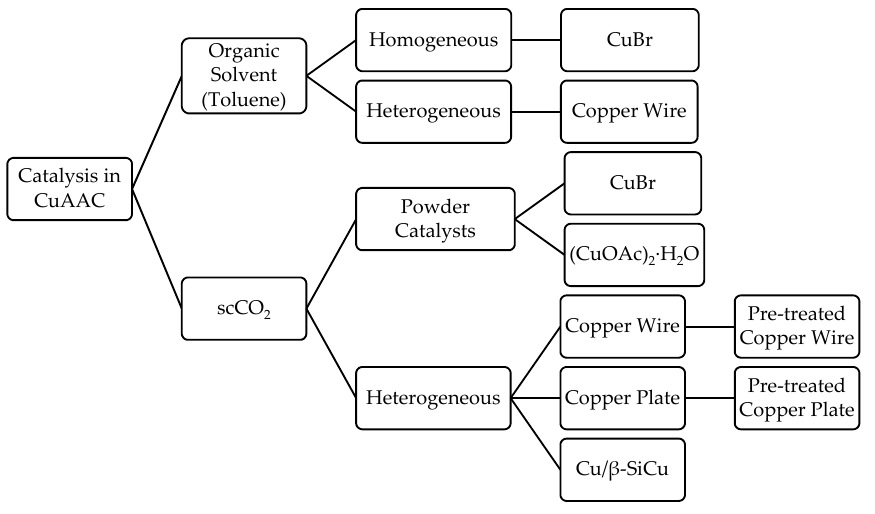
Figure 6. Chart of catalysts used in toluene and scCO 2 . Table 1. Yield of CuAAC reaction with different catalysts using an organic